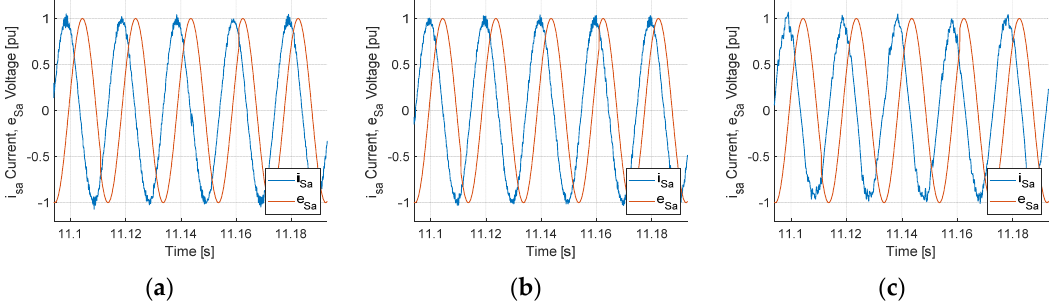
Figure 14. One phase grid current in capacitive mode: ( a ) CHB (4000 µ F ) ; ( b ) CHB ( 1200 µ F ) ; ( c ) CHB-SDC ( 1200 µ F ) . Table 3. Comparison between the current total harmonic distortion of topologies. Operation